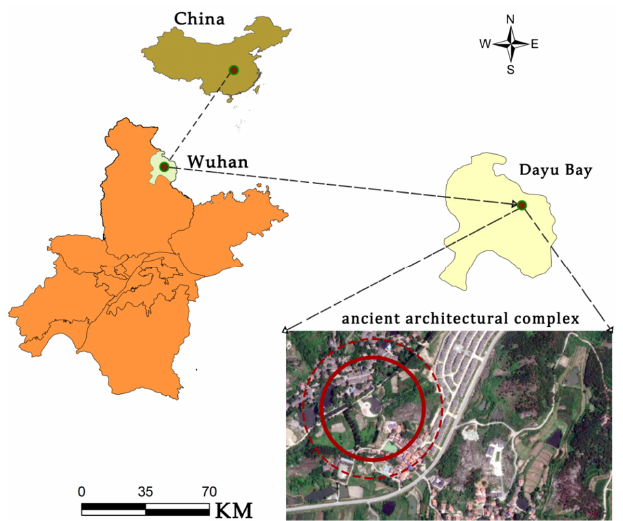
Figure 1. Location analysis diagram of Huangpi Dayu Bay. Source: Google Maps intercept image.